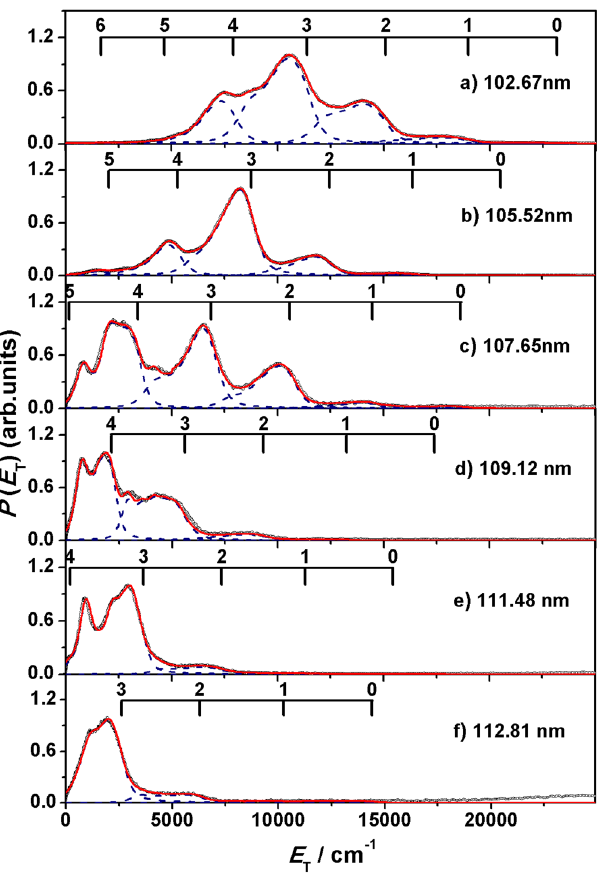
Fig. 3 Wavelength-dependent product kinetic energy distributions from H 2 O photolysis. The product total kinetic energy distribution ( E T ) spectra derived from the images shown in Fig. 2, in red, along with the best- fi t simulation of the spectra, in navy. The superposed combs indicate the E T values associated with formation of the various vibrational states of H 2 (X). The raw data are provided as a Source Data fi le.